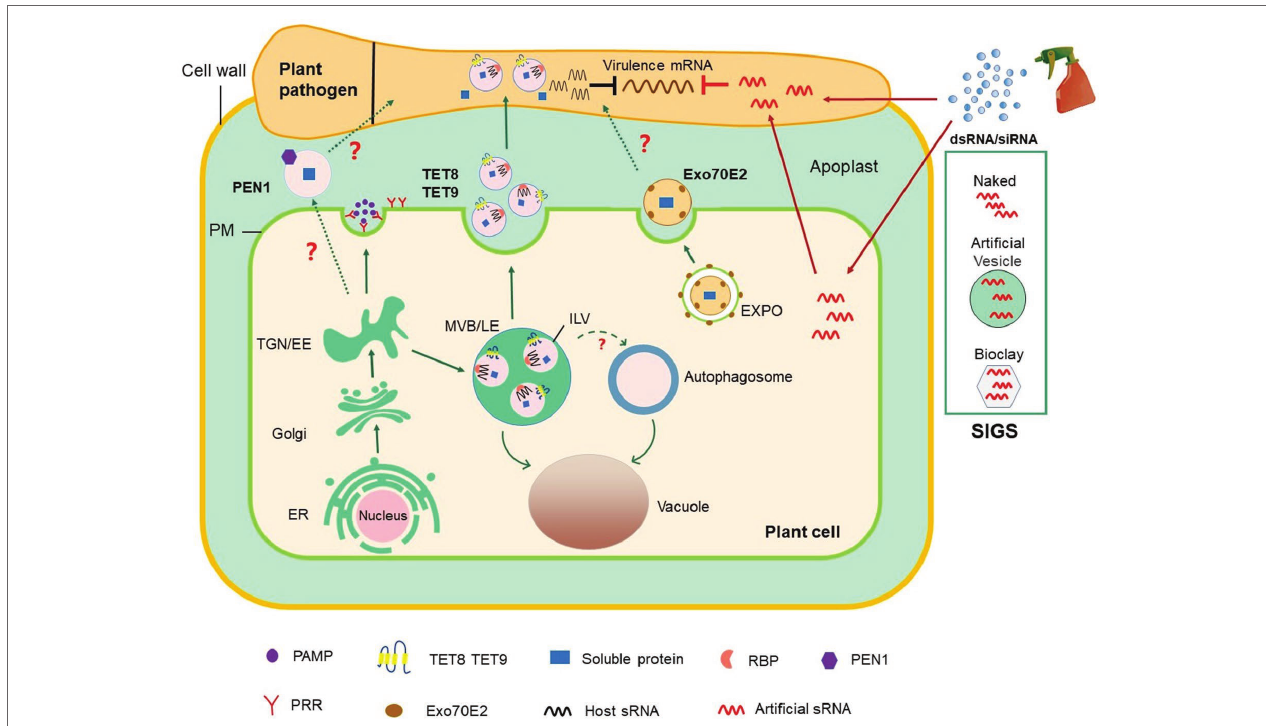
FIGURE 1 | Roles of EV-mediated RNAi in plant–microbial interactions and plant protection. The conventional secretion pathway delivers PAMPs to the extracellular space or transport surface PRRs to PM. In unconventional secretion pathway, MVBs release TET8/9-positive EVs, which contain defense proteins and host-derived sRNAs, into the extracellular space. TET8/9-positive EVs contain a variety of RBPs, including AGO1, RHs, and ANNs, which load sRNAs into EVs. PEN1-positive EVs are secreted into the extracellular space with an unknown mechanism (marked with ? in the Figure). EXPO is a novel bilayer membrane organelle that fuses with PM to produce another subtype of EVs. Whether PEN1-positive and EXPO-positive EVs contribute to cross-kingdom RNAi between plant and pathogens (marked with ? in the figure) is unknown. On the basis of the knowledge on cross-kingdom RNAi, the spray application of dsRNAs and sRNAs that target pathogen genes can potentially control plant diseases. In SIGS approaches, dsRNAs are applied exogenously or carried by nanocarriers, such as BioClay and artificial vesicles. Exogenous RNAs can either be directly internalized into fungal cells or indirectly via passage through plant cells before transport into fungal cells. dsRNA, double- stranded RNA; EE, early endosome; ER, endoplasmic reticulum; EVs, extracellular vesicles; EXPO, exocyst-positive organelle; MVB/LE, multivesicular body/late endosome; ILV, intraluminal vesicle; PAMP, pathogen-associated molecular pattern; PEN1, Penetration 1; PM, plasma membrane; PRR, pattern recognition receptor; RBPs, RNA binding protein; SIGS, spray-induced gene silencing; siRNA, small interfering RNA; sRNA, small RNA; TGN, trans -Golgi